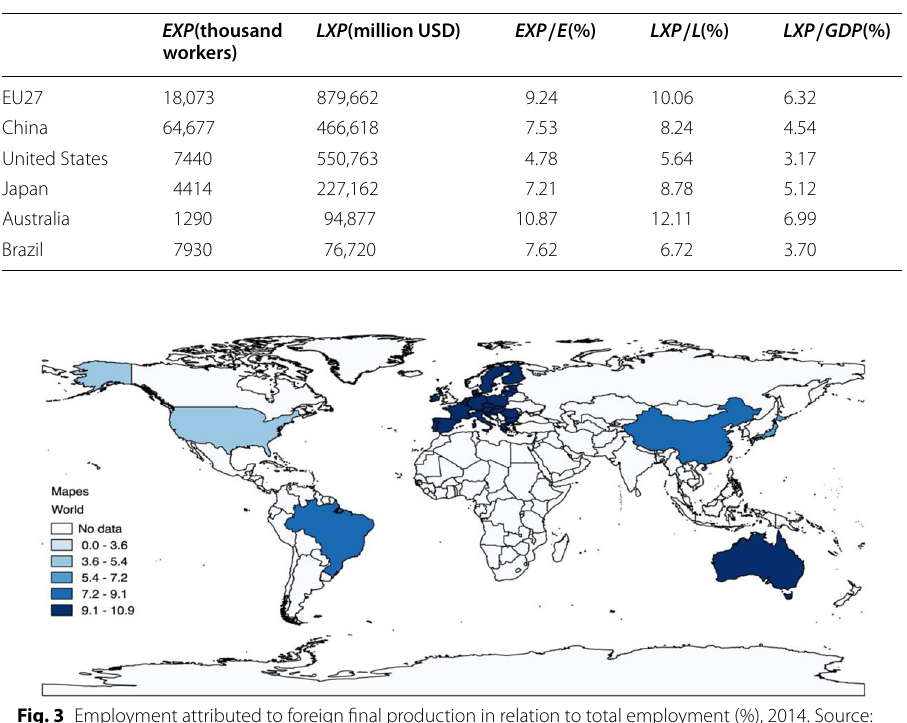
Table 3 Employment impact of foreign final production, 2014. Source: Author’s calculations based on the WIOD